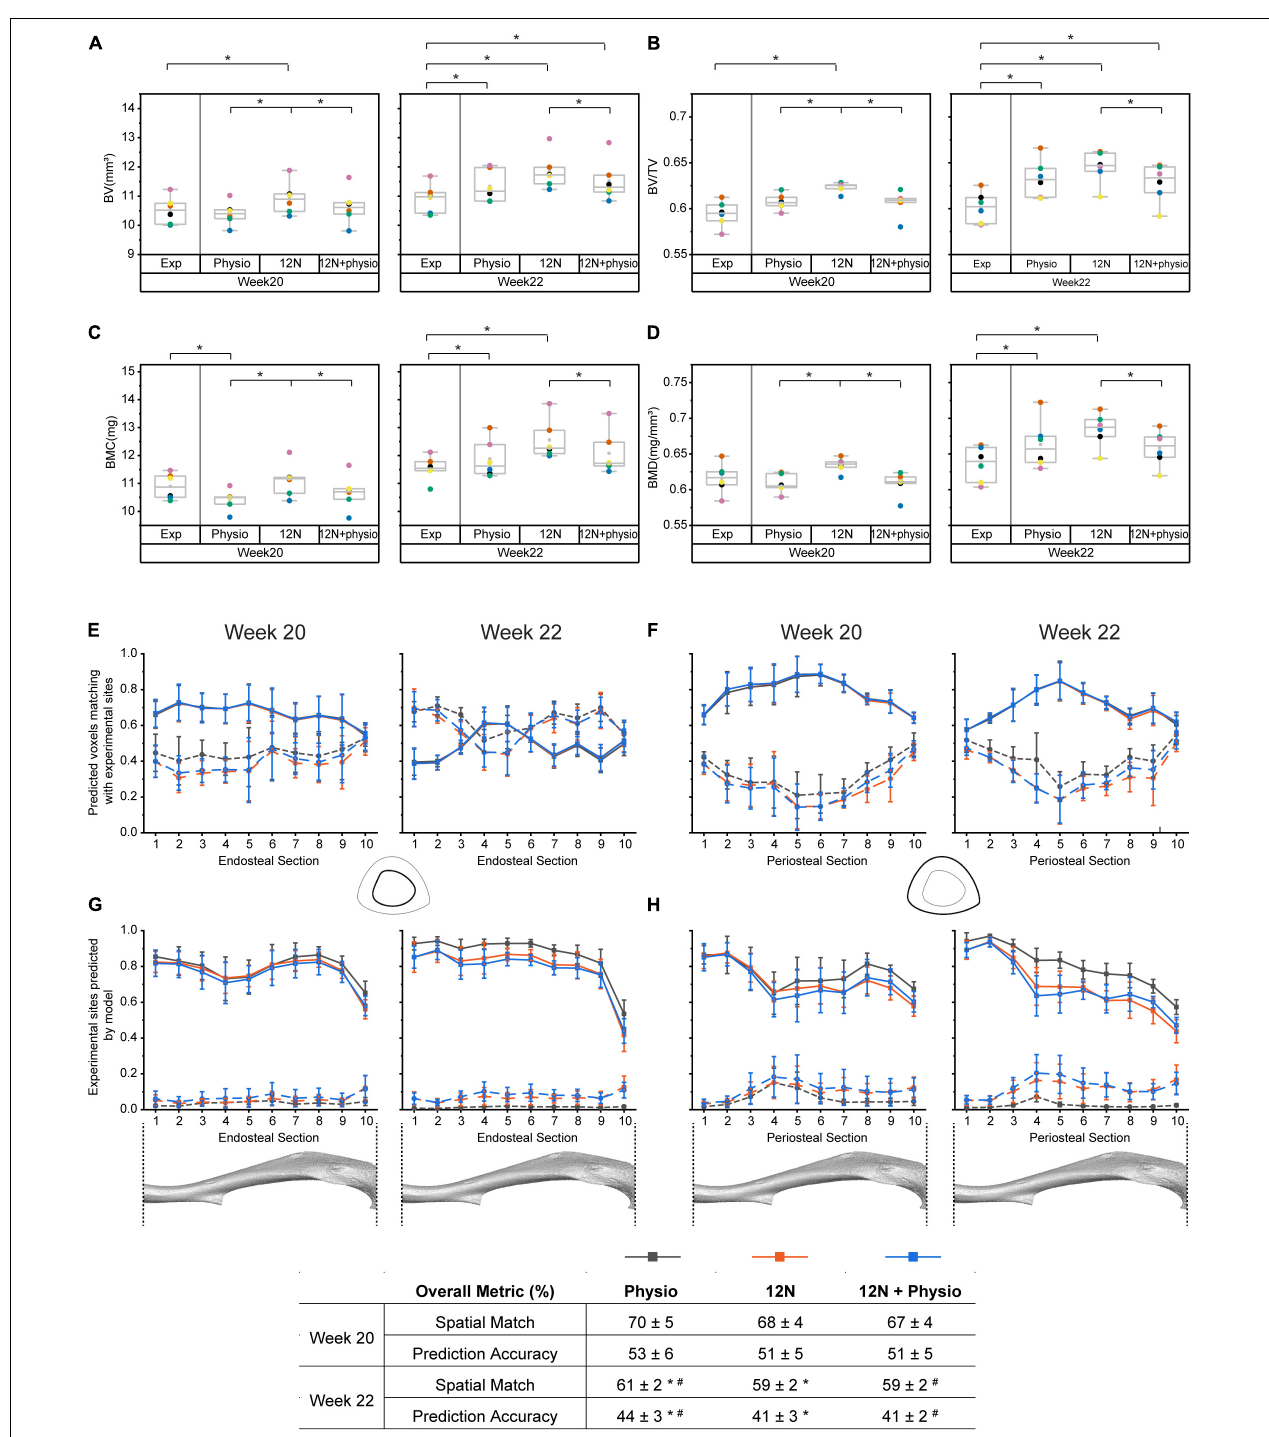
FIGURE 3 | Comparison of the accuracy of different loading conditions on the accuracy of the model prediction. Densitometric parameters were evaluated for: (A) Bone volume (BV), (B) Bone volume fraction (BV/TV). (C) Bone mineral content (BMC), (D) Bone mineral density (BMD). The ability of the model to predict the spatial distribution of bone adapation were assessed along the longitudinal axis of the tibia from distal (1) to proximal (10): (E) Spatial match on the endosteal surface, (F) Spatial match on the periosteal surfaces, (G) Prediction accuracy on the endosteal surface, (H) Prediction accuracy on the periosteal surfaces. Exp: experimental data, Physio: physiological load, 12N: nominal 12N axial load, 12N + physio: combined nominal 12N axial load superimposed on the physiological load. Solid lines indicate apposition while dashed lines indicate resorption. * and # indicate significant differences between the different groups (Wilcoxon signed rank test: p < 0.05).